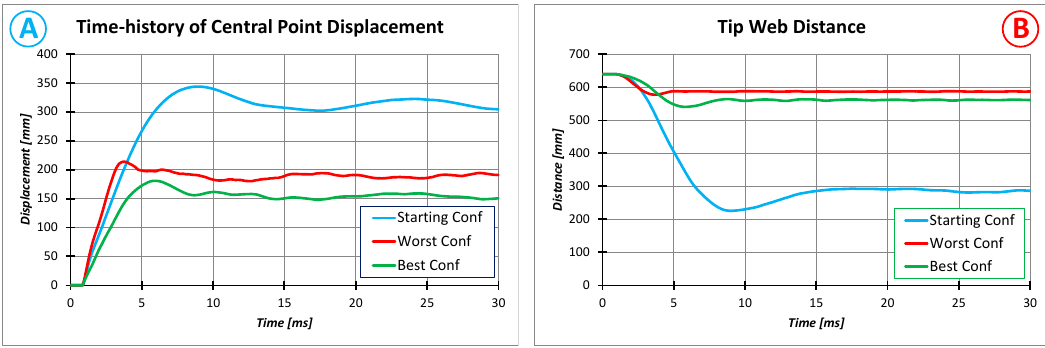
Figure 11. ( A ) Time-history of the displacement along impact direction of the skin central point; ( B ) tip web distance time-history.